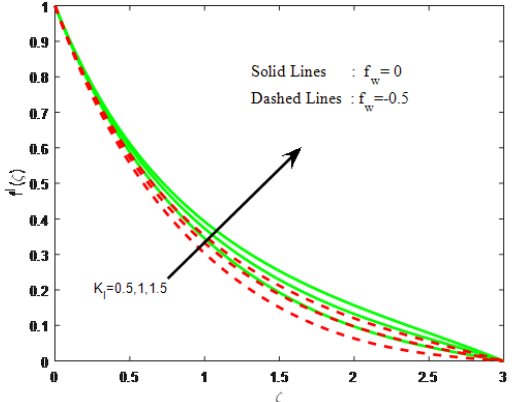
Fig. 15: The effect of chemical reaction parameter ( K l ) on concentra- tion field